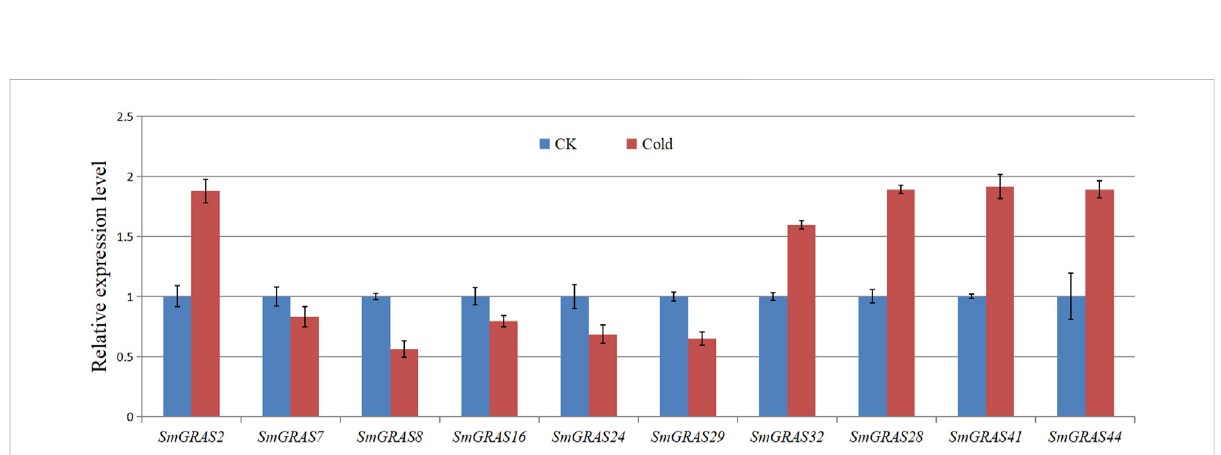
FIGURE 8 Relative expression levels of eight SmGRAS s analyzed using qPCR in response to cold after 12 h treatment compared with that of control (CK). Thebarsofexpressionwithandwithouthypothermiatreatment areshown inredand blue,respectively. Y -axisrepresentsrelativeexpression values, and X -axis represents different genes. Error bars are standard deviations of three biological